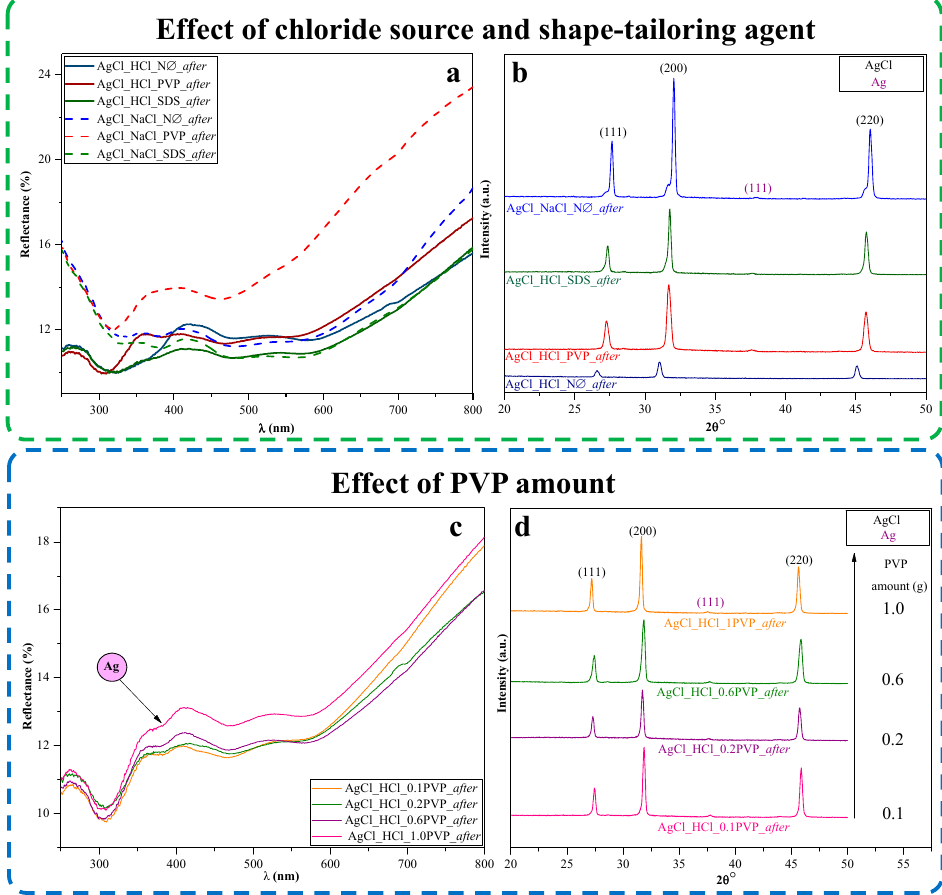
Figure 8. Characterization of AgCl photocatalysts after photocatalytic processes: effect of chloride source and shape-tailoring agent (top row): ( a ) optical and ( b ) structural properties; effect of PVP amount (bottom row): ( c ) optical and ( d ) structural characters.